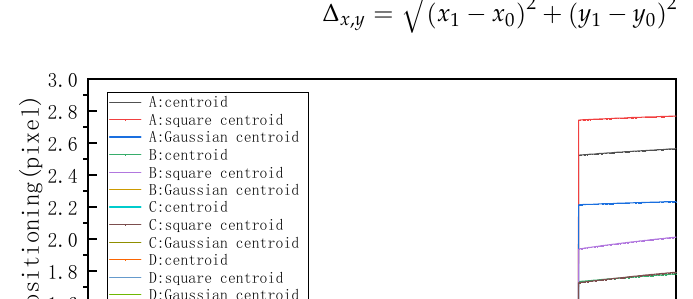
The centroid position ( x 1 , y 1 ) is calculated using different centroid positioning methods for the five cases, and the error of centroid positioning ∆ x , y is calculated according to Equation (5). The result is shown in Figure 7.